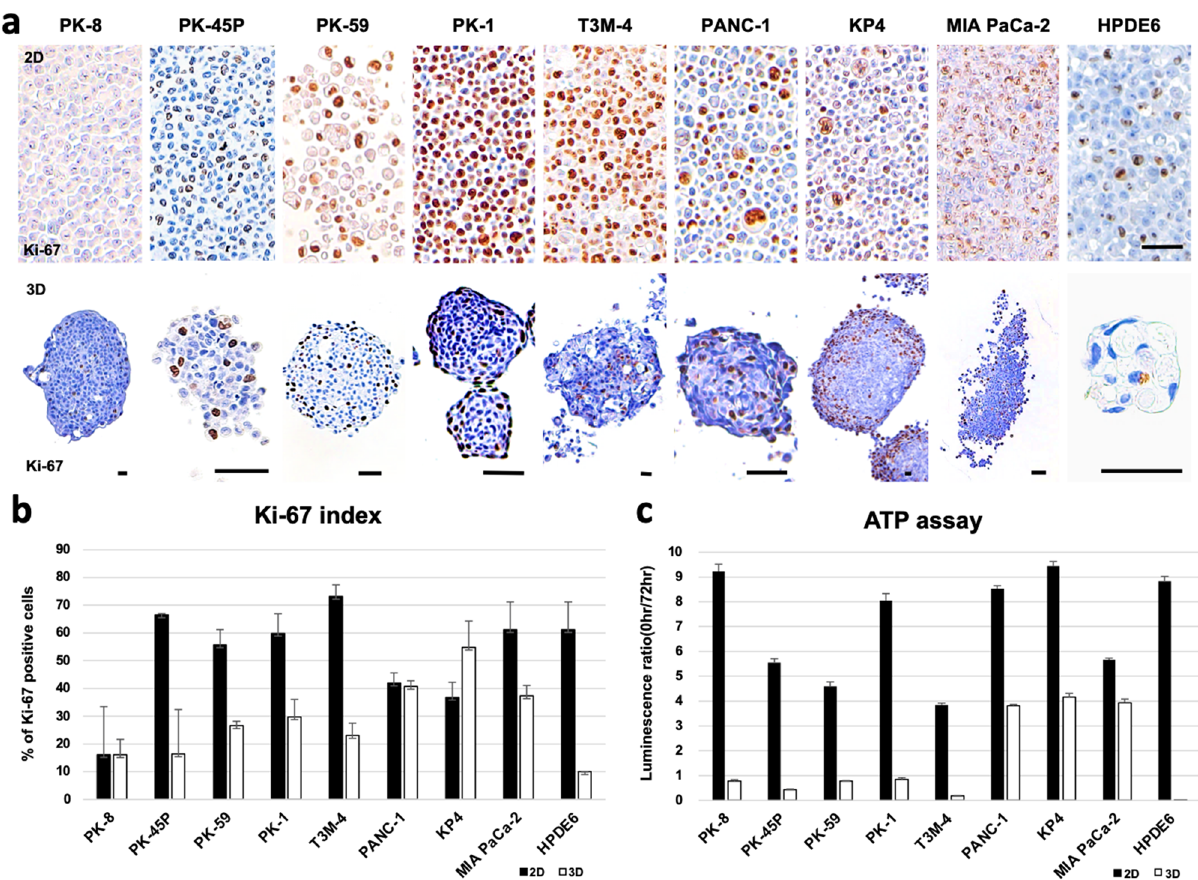
Figure 3. Analysis of cell proliferation ability. ( a ) Immunocytochemical analysis of Ki-67 in PDAC and HPDE6 cells under 2D (upper row) and 3D (lower row) culture conditions. Scale bar = 50 μm. ( b ) Quantification of Ki-67-positive cells. Data are shown as the mean ± SD. ( c ) ATP assay shows that PANC-1, KP4, and MIA PaCa-2 cells in 3D culture had high luminescence signals. Data are shown as the mean ± SD. ATP assay was repeated two times in